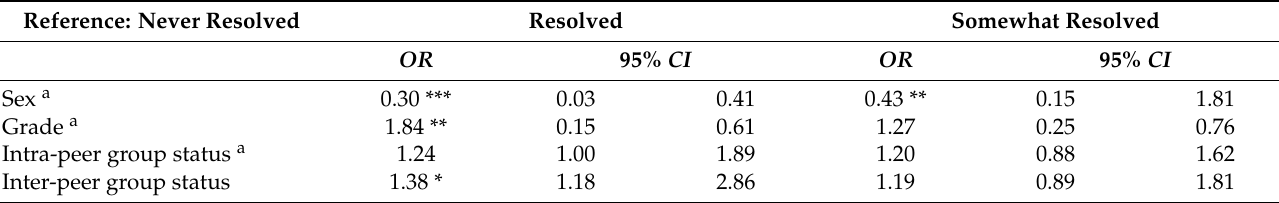
Table 4. Multinomial logistic regression for the three current victimization status ( n =